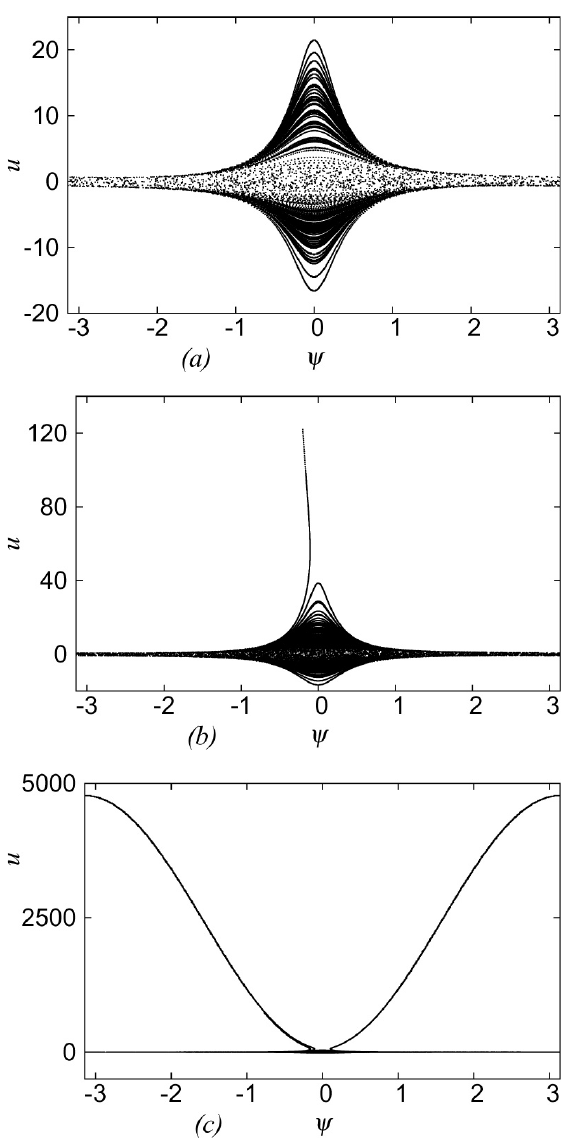
Fig. 14. Dynamics of the system (121) in the off-resonant case. Here Q = 0 . 367 and w = π/ 2 × 10 − 4 . (a) 2 · 10 4 , (b) 3 . 5 × 10 4 , and (c) 8 × 10 4 iterations of a single initial